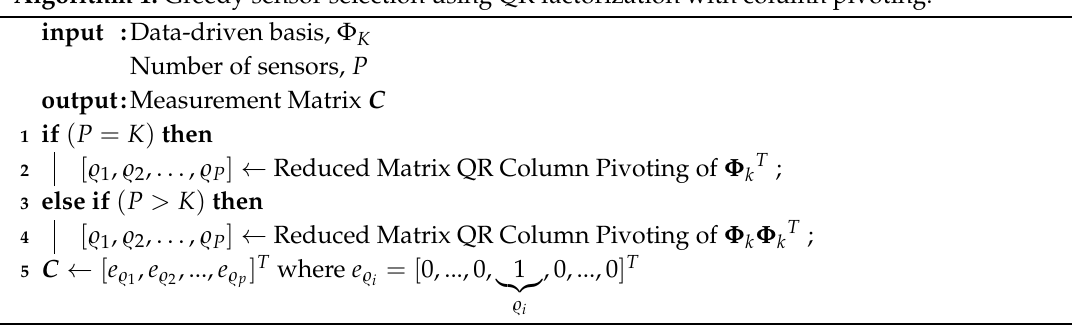
Algorithm 1: Greedy sensor selection using QR factorization with column